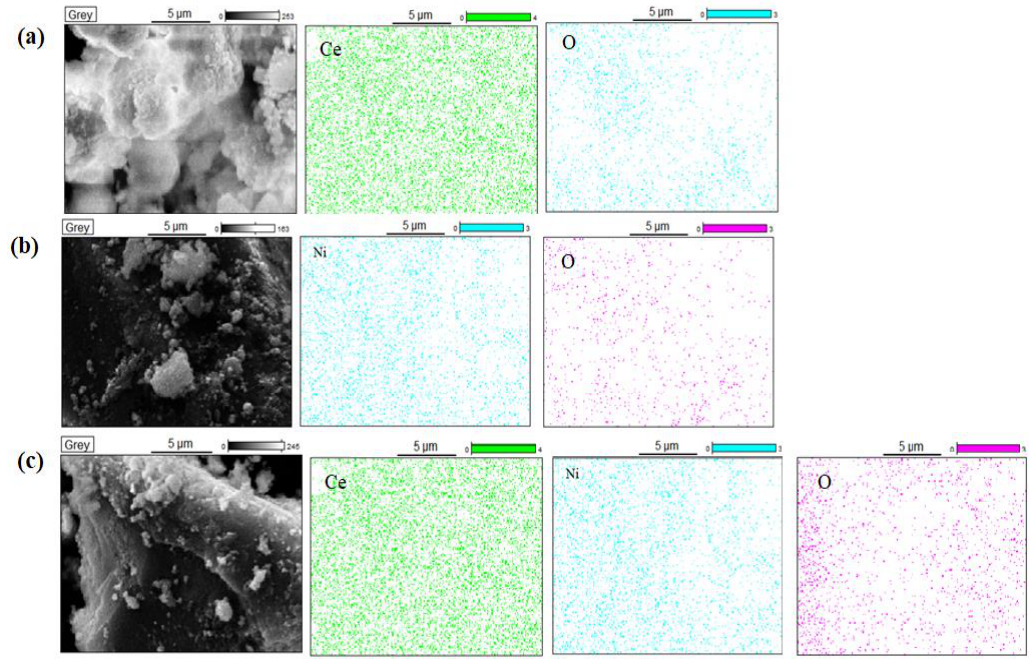
Figure 6. Mapping of ( a ) CeO 2 NPs (wheat husk extract) and ( b ) NiONPs (rice husk extract) and ( c ) their CeO 2 /NiO nanocomposite.